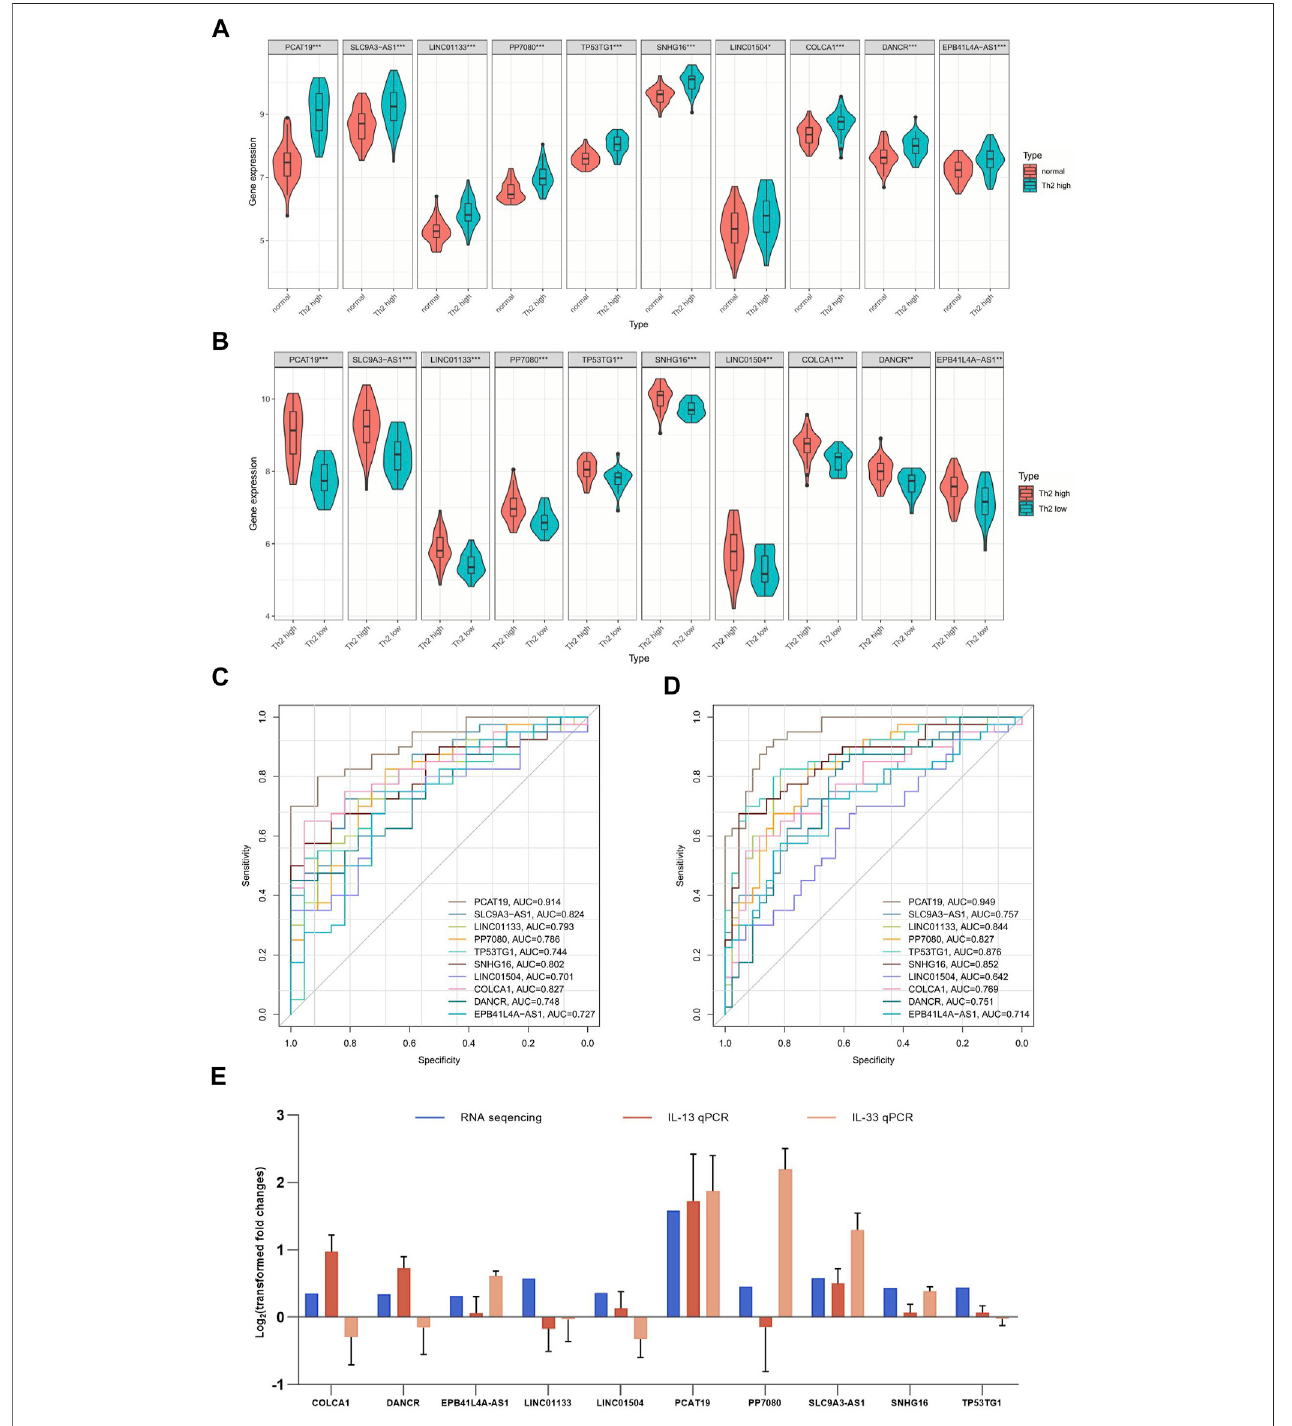
FIGURE 4 | ROC analysis and gene expression of 10 overlapping upregulated lncRNAs. (A) ROC analysis of 10 overlapping upregulated lncRNAs between patients with Th2 high asthma and health controls. (B) ROC analysis of 10 overlapping upregulated lncRNAs between patients with Th2 high asthma and patients with Th2 low asthma. (C) Expression of 10 overlapping upregulated lncRNAs in patients with Th2 high asthma and normal samples. (D) Expression of 10 overlapping upregulatedlncRNAsinTh2highasthmaandTh2lowasthma. (E) Thelevelofidenti fi edlncRNAs inIL-13/IL-33-induced 16HBEcellsmeasured byqRT-PCR.* p < 0.05; ** p < 0.01.